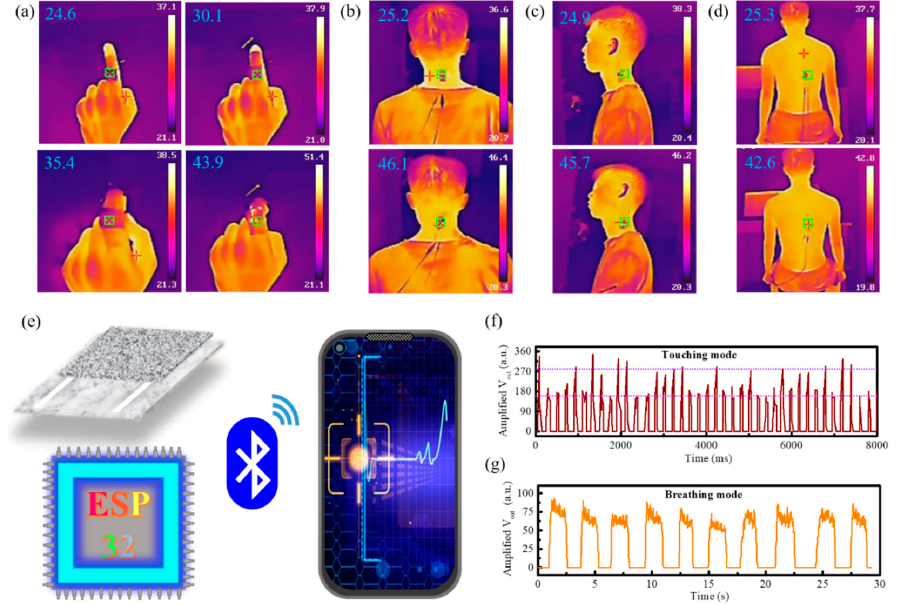
Figure 5. Thermotherapy applications and wireless real-time monitoring of the sensor. ( a ) Temperature dependent with various bending angles. ( b – d ) Temperature changes during cervical and lumbar spine twisting. ( e ) Wearable sensor system for wireless transmission and data storage function configuration. ( f ) Wireless function spread on touching mode. ( g ) Respiratory signals of mobile terminal by attaching the device to the chest.